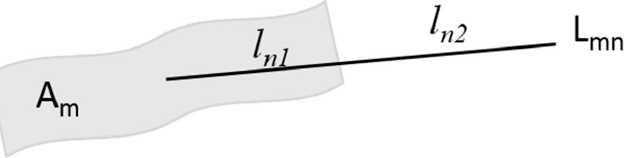
Figure 13. Schematic diagram of road fusion condition judgment for optical and SAR extraction.